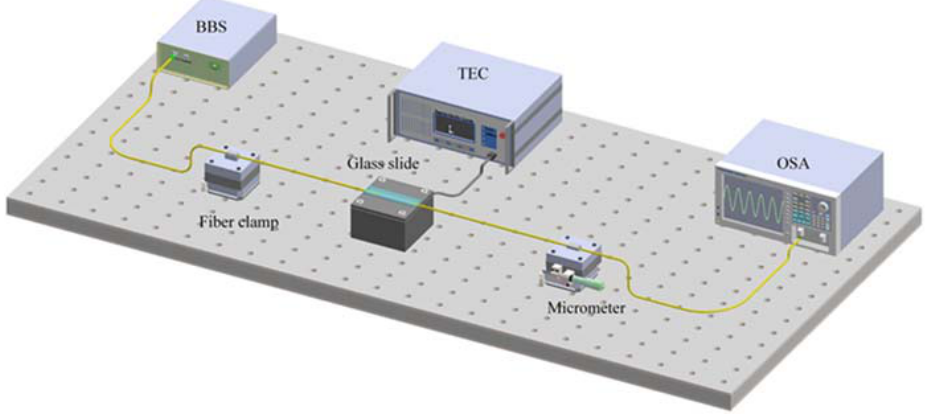
Figure 12. Measurement system for temperature sensing.